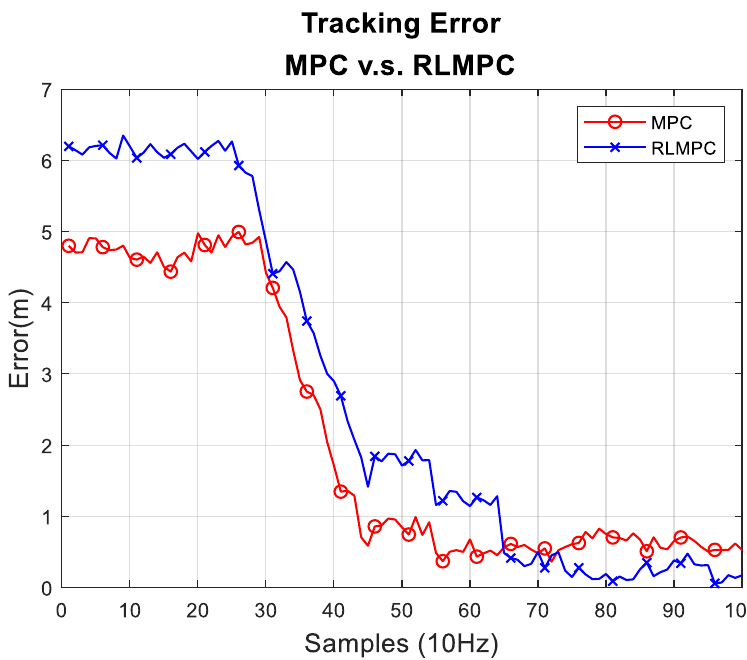
Figure 11. Tracking error comparison of MPC and RLMPC in Scenario 1.